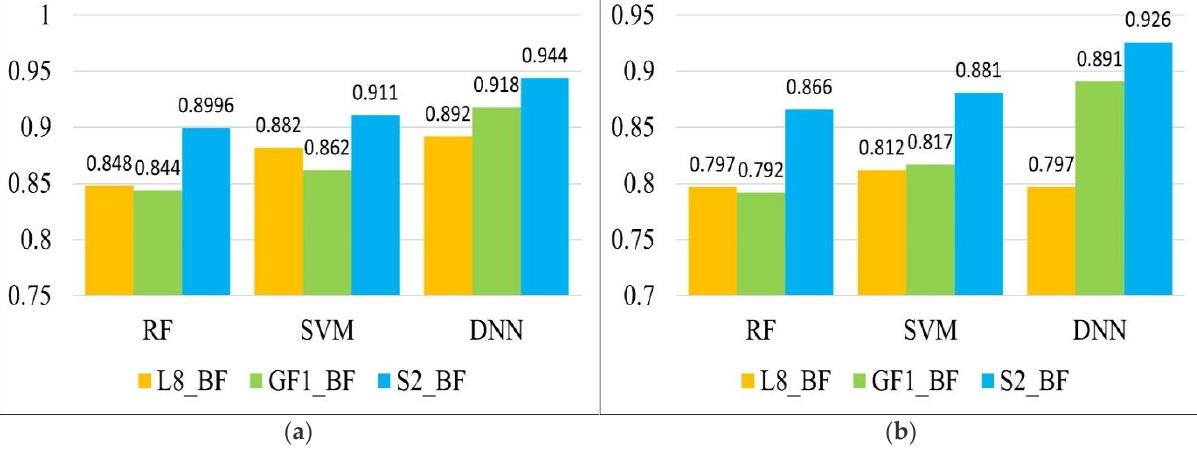
Figure 12. ( a ) Overall accuracy of different BI models; ( b ) kappa coefficient of different BI models.